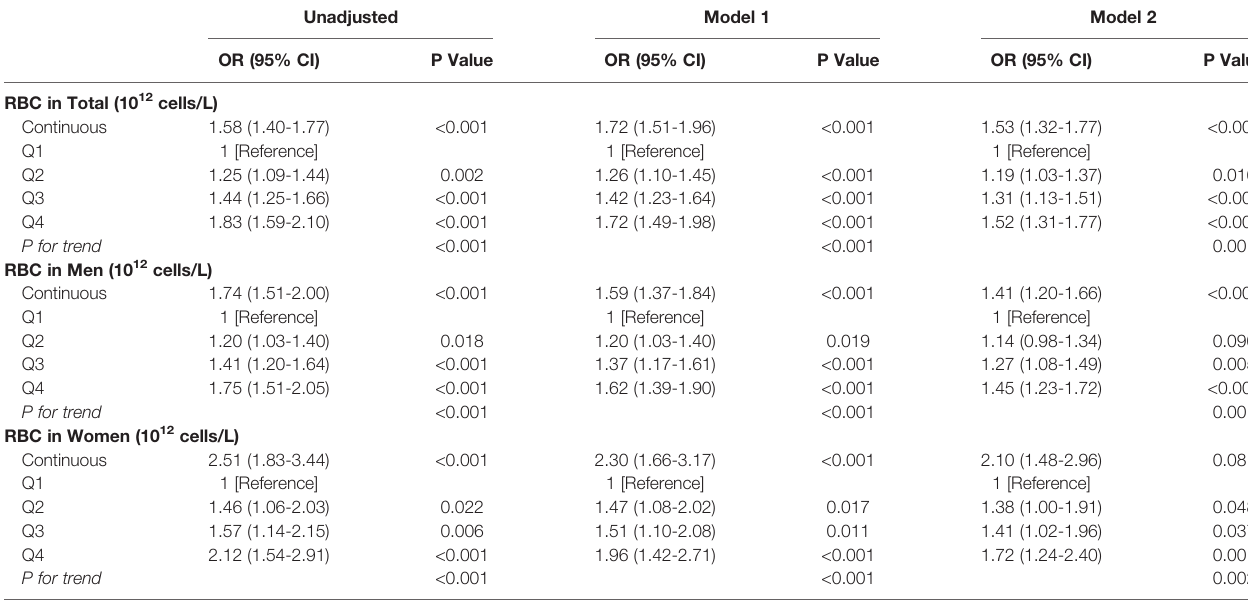
TABLE 3 | GEE analysis for NAFLD progression based on RBC count during